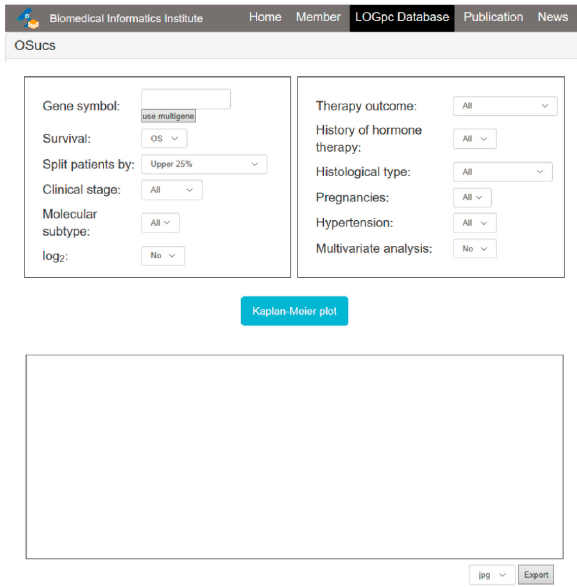
Figure 1. Screenshot of the main interface of OSucs at http://bioinfo.henu.edu.cn/UCS/UCSList.jsp.